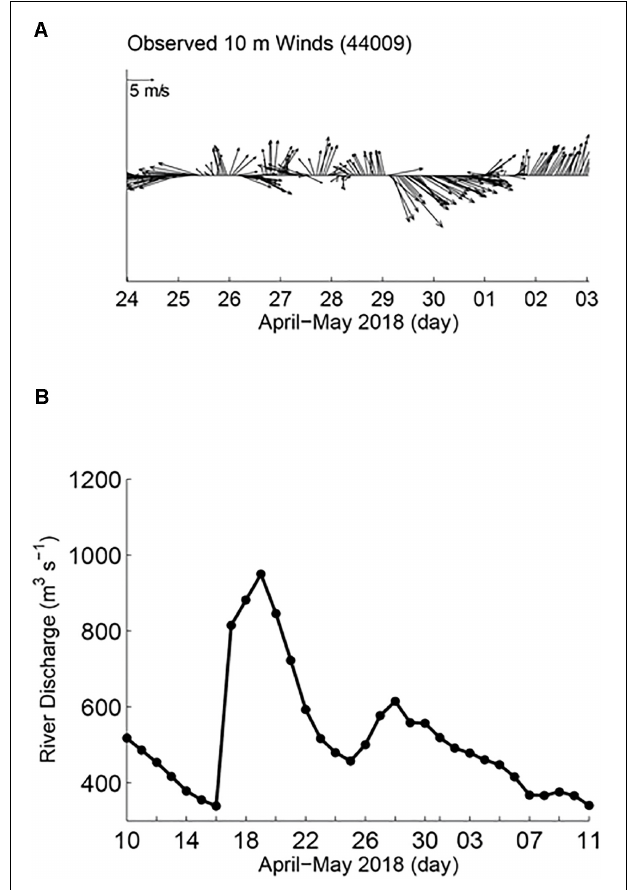
FIGURE 2 | Broader scale physical properties influencing the study area including, (A) time-series of wind direction and speed and (B) river discharge volume in the Delaware